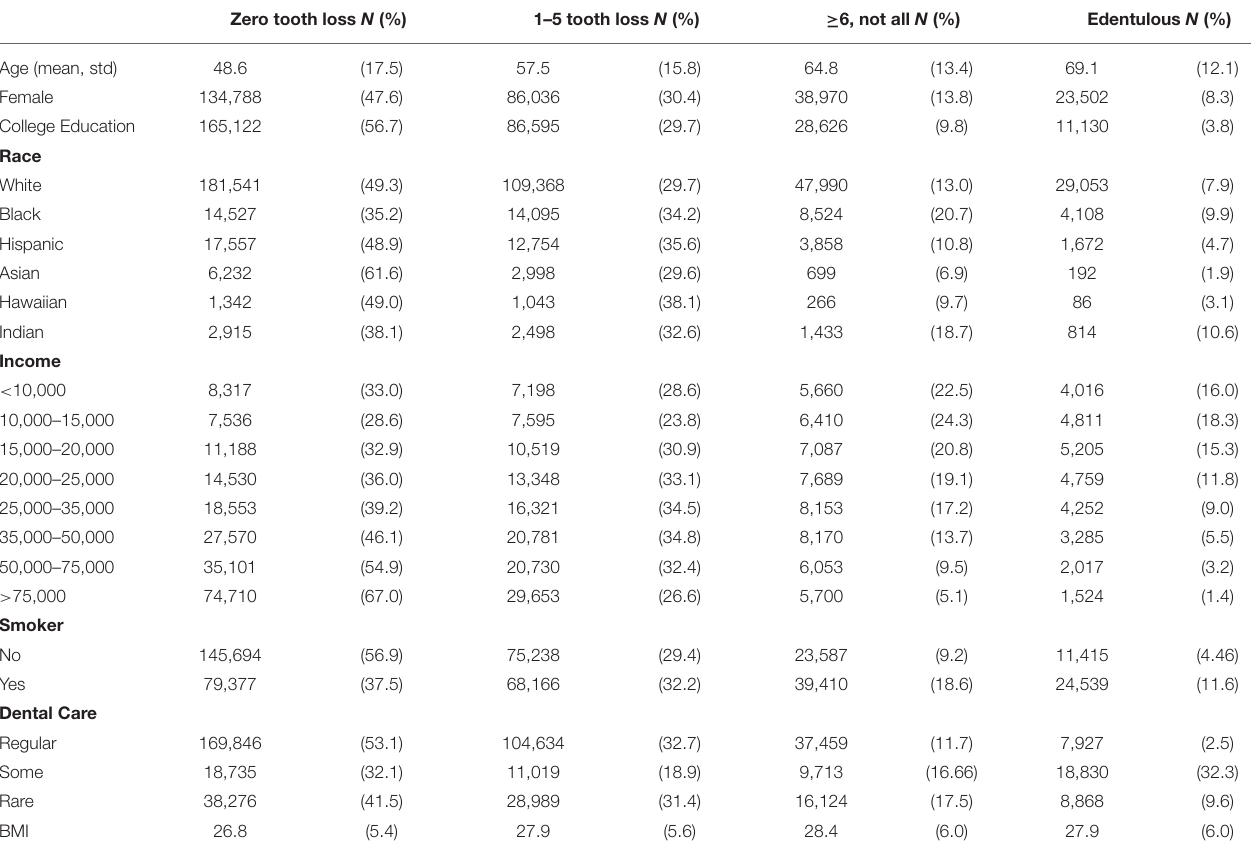
TABLE 2 | Sociodemographic and health risk factors by tooth loss categories, US adults, Behavioral Risk Factor Surveillance System, 2012. Zero tooth loss N